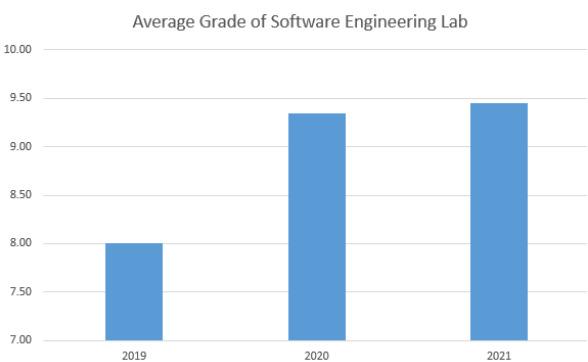
Figure 13. Average Student Grades for the Software Engineering Lab.